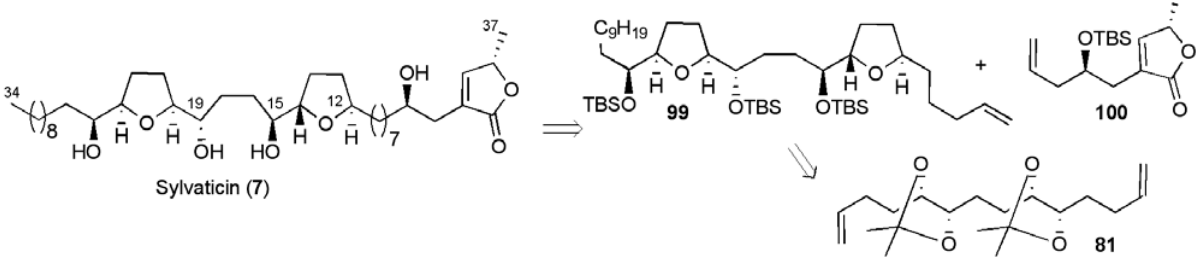
Figure 14. Donohoe’s approach to sylvaticin ( 7